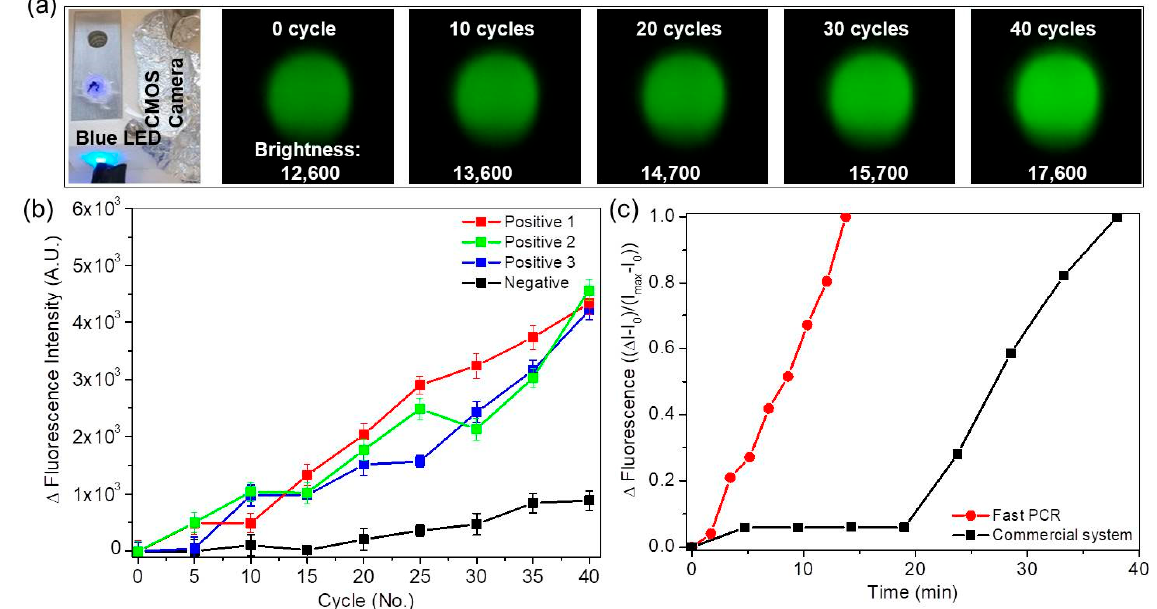
Figure 5. ( a ) Photographs of fluorescence optical setup and captured fluorescence images during PCR amplification every fifth cycle. Fluorescence images change from dark green to light green during PCR amplification. Numbers on fluorescence images are calculated brightnesses. ( b ) Variations in brightness of positive and negative samples with respect to cycles. ( c ) Relative fluorescence intensity (( Δ I − I (0))/( I (max) − I (0)) with respect to amplification time for the fast PCR system (red) and the commercial PCR device (black).